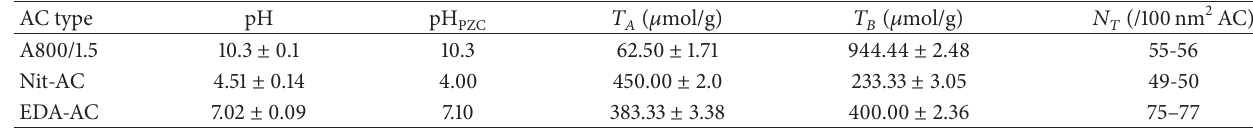
Table 3: Surface functionalities of activated carbon samples.